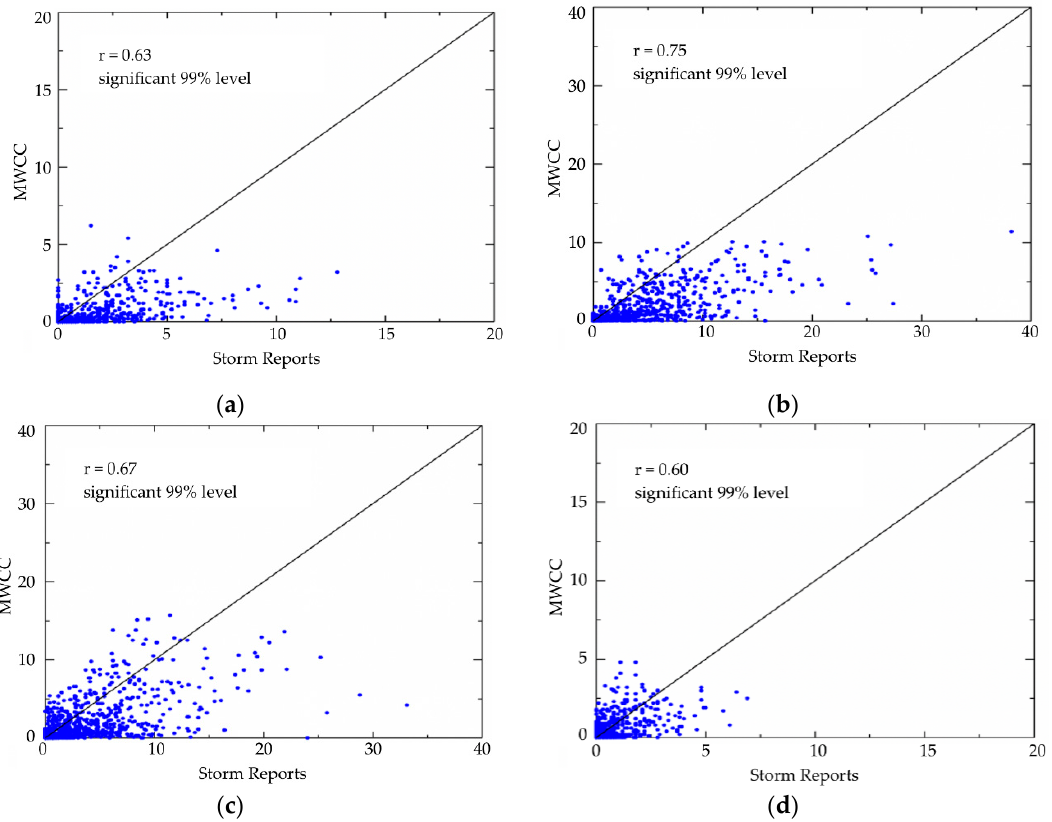
Figure 11. ( a ) March, ( b ) May, ( c ) June and ( d ) September scatter plots for the mean 2000–2011 maps of Figure 10.